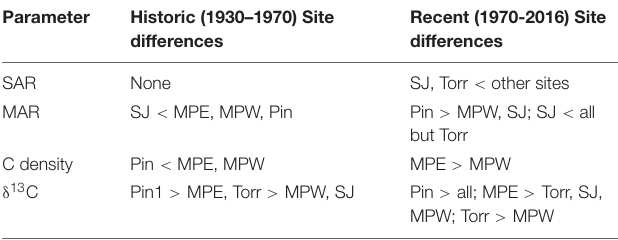
TABLE 2 | Site comparisons of sediment accretion rate (SAR), mangrove accretion rate (MAR), carbon (C) density, and C stable isotope ratio ( δ 13 C) within either the historic or recent time